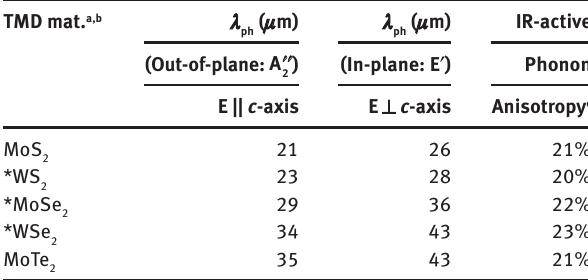
Table 6: Out-of-plane